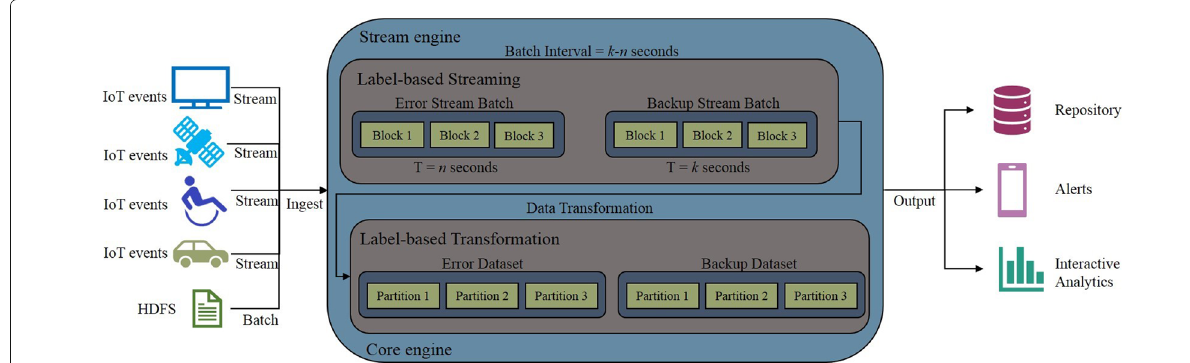
Fig. 3 Label-based Heterogeneous Streaming Workflow Lemma-1: SE o , p , q =